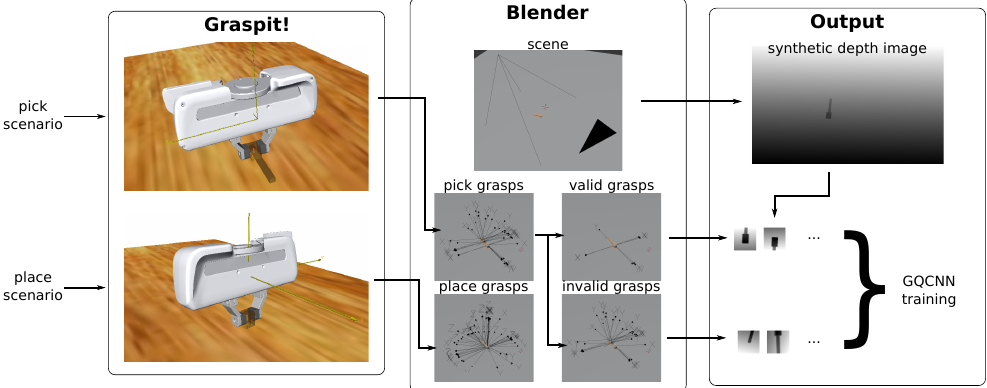
Figure 1. Synthetic data generation and GQCNN training